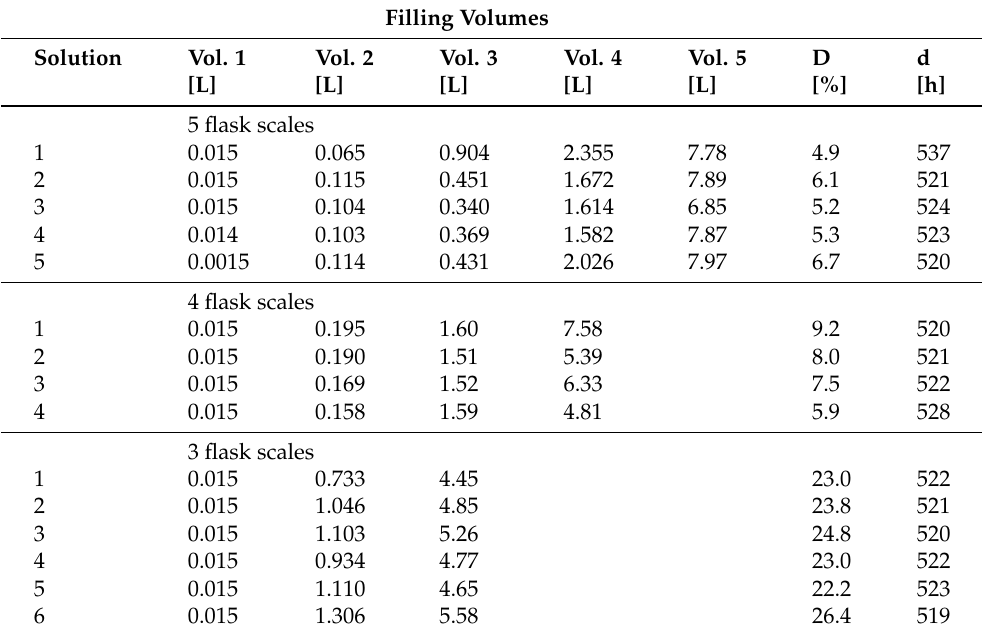
Table 4. Pareto optimal solutions concerning the choice of filling volumes in shake flask scales, for 3, 4 and 5 shake flask scales. The following bioreactor filling volumes are 40 L, 320 L and 2210 L. The averaged filling volumes in L, the resulting deviation rate ( D ) in % and seed train duration d in h are listed for each